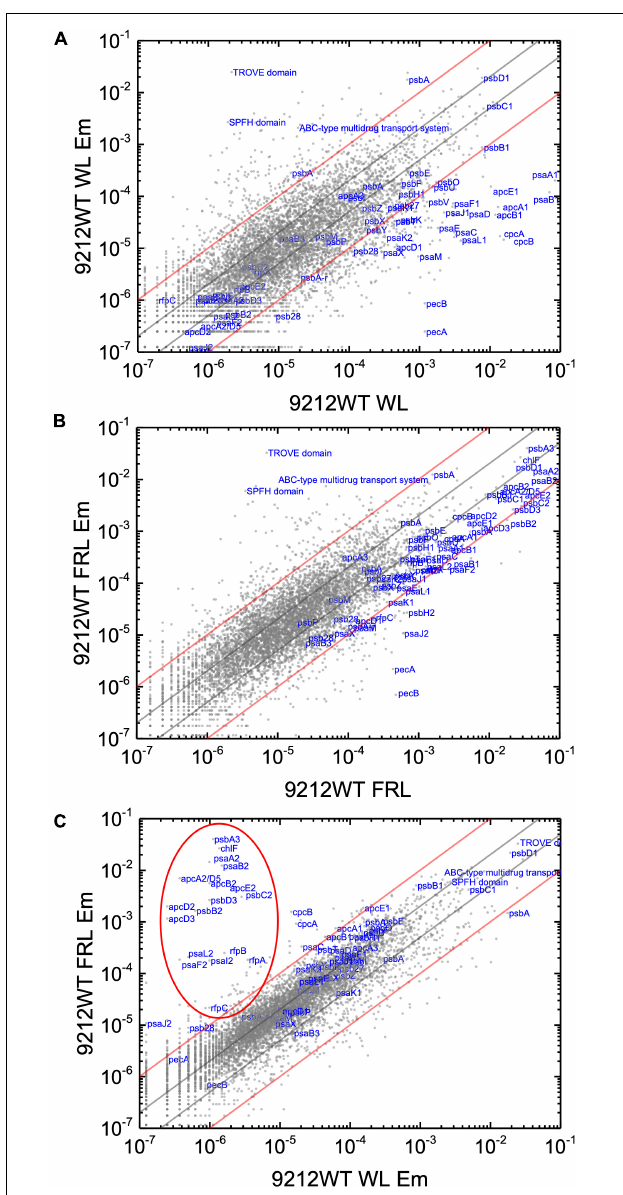
FIGURE 6 | Scatter plots showing comparisons of relative transcript abundances for C. fritschii 9212 cells grown with or without Em in WL and FRL. Scatter plot of RNAseq data comparing relative transcript abundance for WT C. fritschii 9212 cells grown (A) in WL (9212WT WL) and supplemented with Em (5 µ g ml − 1 ) for 48 h in WL (9212WT WL Em) and (B) in FRL (9212 WT FRL) for 48 h and supplemented with Em (5 µ g ml − 1 ) for another 48 h in FRL (9212WT FRL Em). An additional comparison of relative transcript abundances for (9212WT WL Em) and (9212WT FRL Em) is shown in (C) . Each gray dot represents one gene. The X - and Y -axes represent normalized transcript abundances for each condition. Genes of interest, including genes in FaRLiP gene cluster (in the red oval, except psaJ2 ), and genes encoding PSI, PSII, and PBP/PBS subunits are labeled in blue font. Genes in the FaRLiP gene cluster are not circled because relative transcript abundances of these genes are not different from those of most of other genes under the conditions shown in (A,B) . The gray and red diagonals indicate the thresholds for a 2-fold and 10-fold increase and a 50 and 10% reduction in relative transcript abundance,